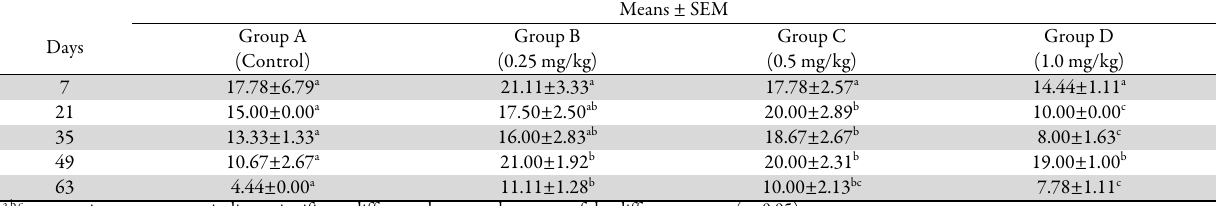
Table 4. Mean serum very low density lipoprotein cholesterol concentration (mg/dl) of albino rats given graded doses of whole quail egg per kilogram body weight (± SEM)